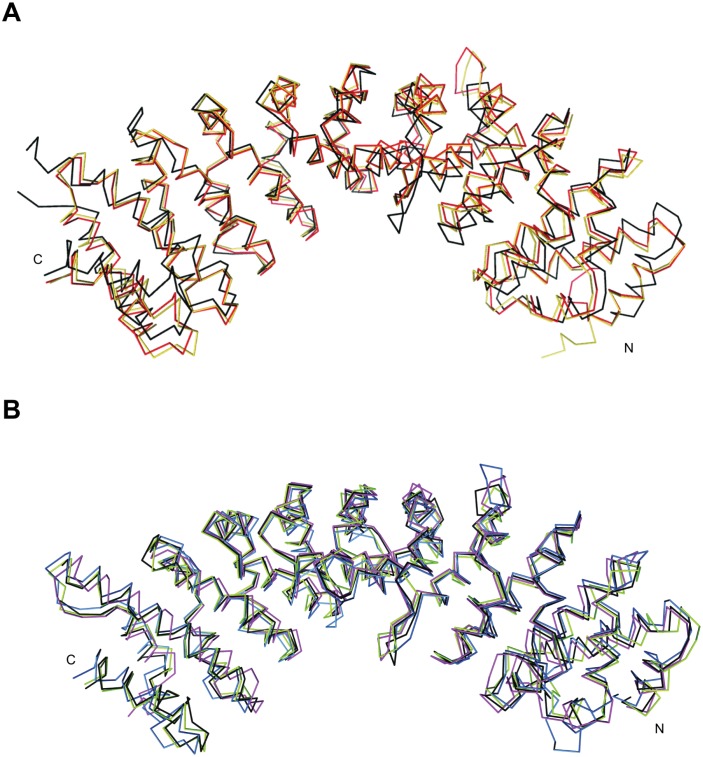
Comparison among Impα crystal structures from different organisms.The Impα proteins were superimposed using the Cα atoms of each protein (residues 83 -505) (a) NcImpα, MmImpα (PDB ID: 3UL1) and HsImpα1 (PDB ID: 4WV6) are represented in black, red and orange, respectively. (b) NcImpα, OsImpα (PDB ID: 4BQK), ScImpα (PDB ID: 1BK5) and HsImpα5 (PDB ID: 2JDQ) are represented in black, blue, green and pink, respectively.